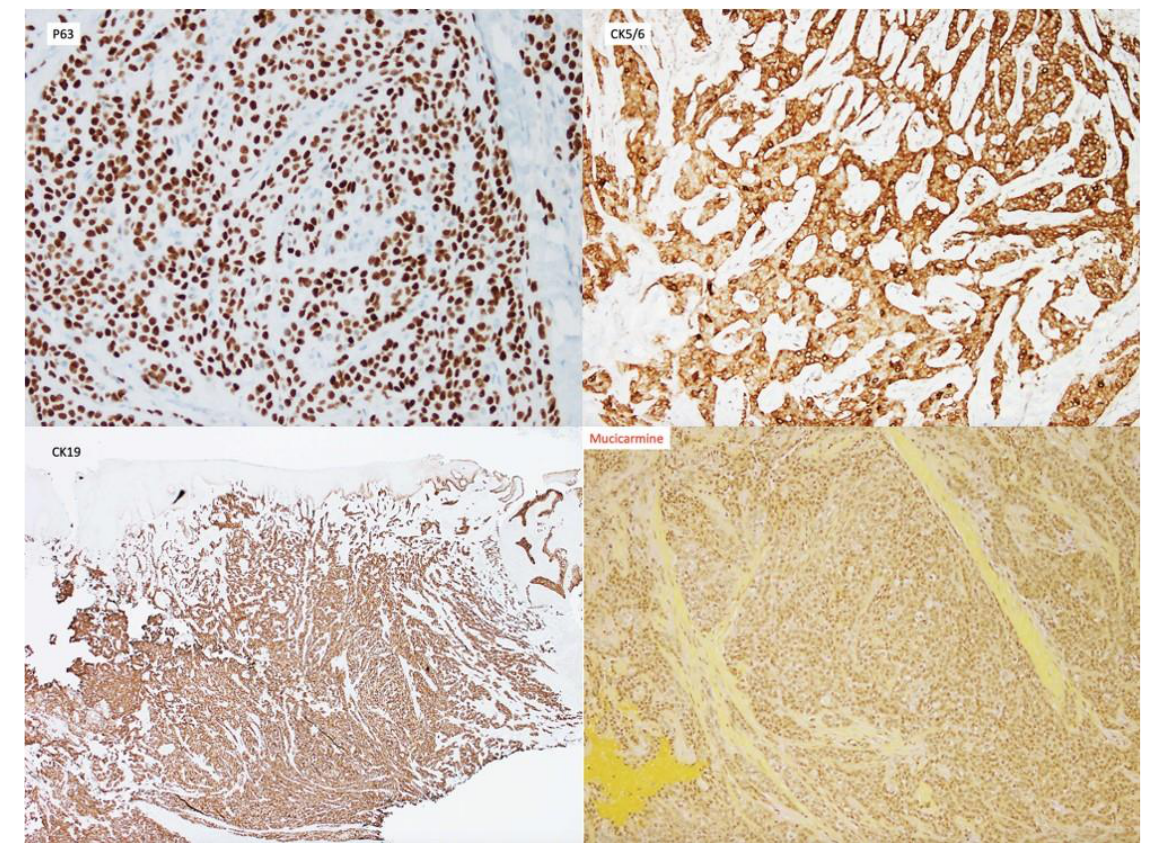
Figure 3. Immunohistochemistry was diffusely positive for p63 (100×), CK5/6 (100×), CK19 (40×) and negative for mucicarmine (100×).